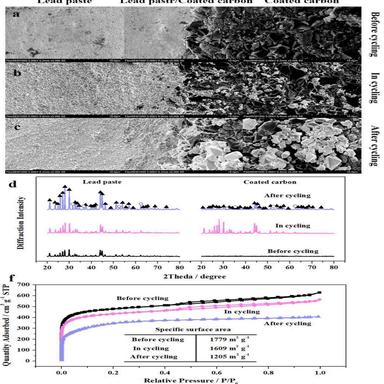
(a-d) and (e) SEM images and XRD pattern of the carbon coating negative electrode during cycling. (f) BET pattern of the coated carbon during cycling.